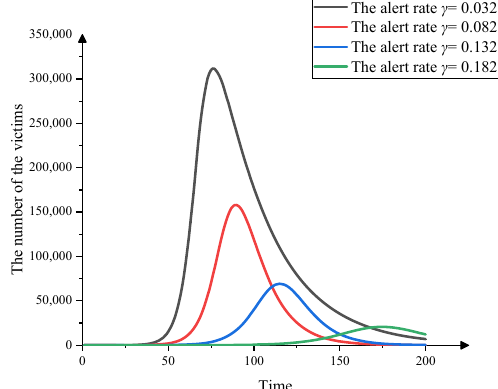
Figure 11. Impact of increased alert rates on fraud dissemination.